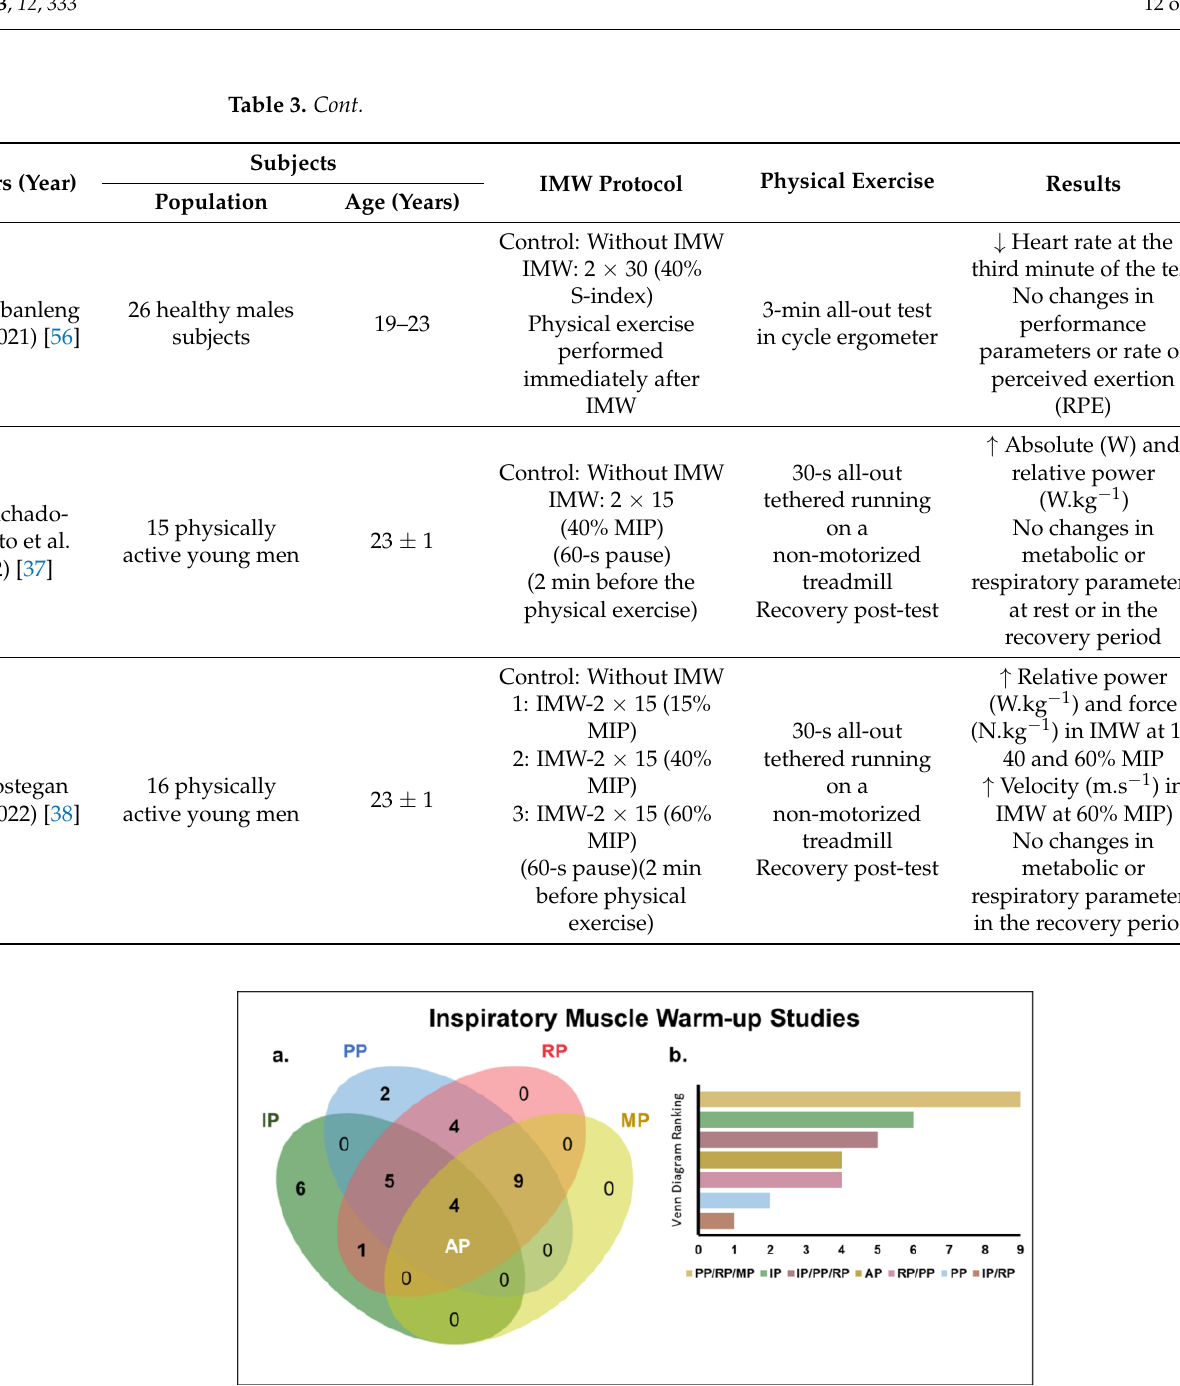
Figure 4. Inspiratory-muscle-warm-up studies. ( a ) Venn diagram [57] of the intersection of studies on the effects of inspiratory-muscle warm-up in relation to the investigated parameters. ( b ) Ranking of the intersections of the Venn diagram (number of studies evaluating the investigated parameters). All parameters (AP); inspiratory parameters (IP); performance parameters (PP); respiratory parameters (RP); and metabolic parameters (MP).